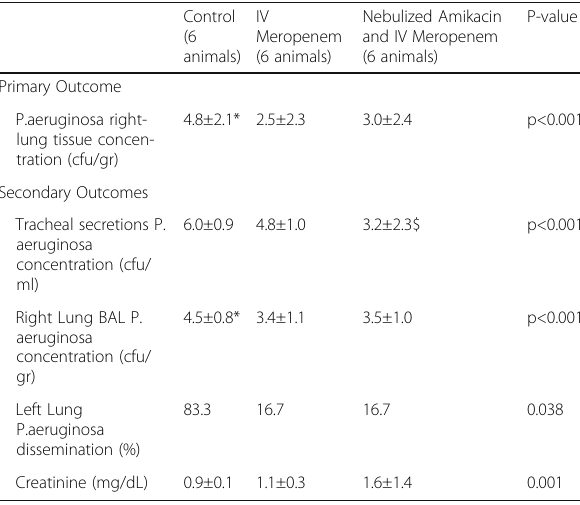
Table 1 (abstract 0073). (*p<0.05 vs. IV-MER and AMK-MER groups; $ p<0.05 vs. control and IV-MER